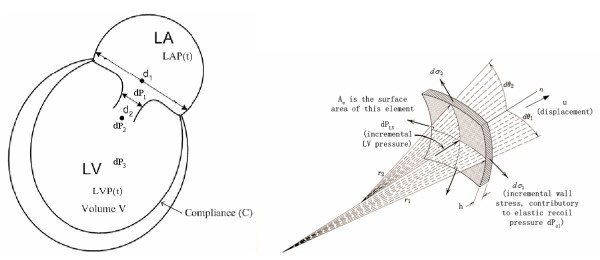
Dynamic equilibrium of a myocardial element. Element mass me = ρ(2r1dθ1)(2r2dθ2)h = (ρh)(4r1r2dθ1θ2) = ρhAe = msAe; dσi = (dPel)(ri) / (2h), (i = 1, 2); dPel is the incremental elastic-recoil pressure. For dynamic equilibrium of the myocardial element, me + 2(dσ1)(2r2dθ2h) + 2(dσ2)(2r1dθ1h) - AedPLV = 0, or me + AedPel - AedPLV = 0. For our LV spherical geometry model, r1 = r2 and dσ1 = dσ2.